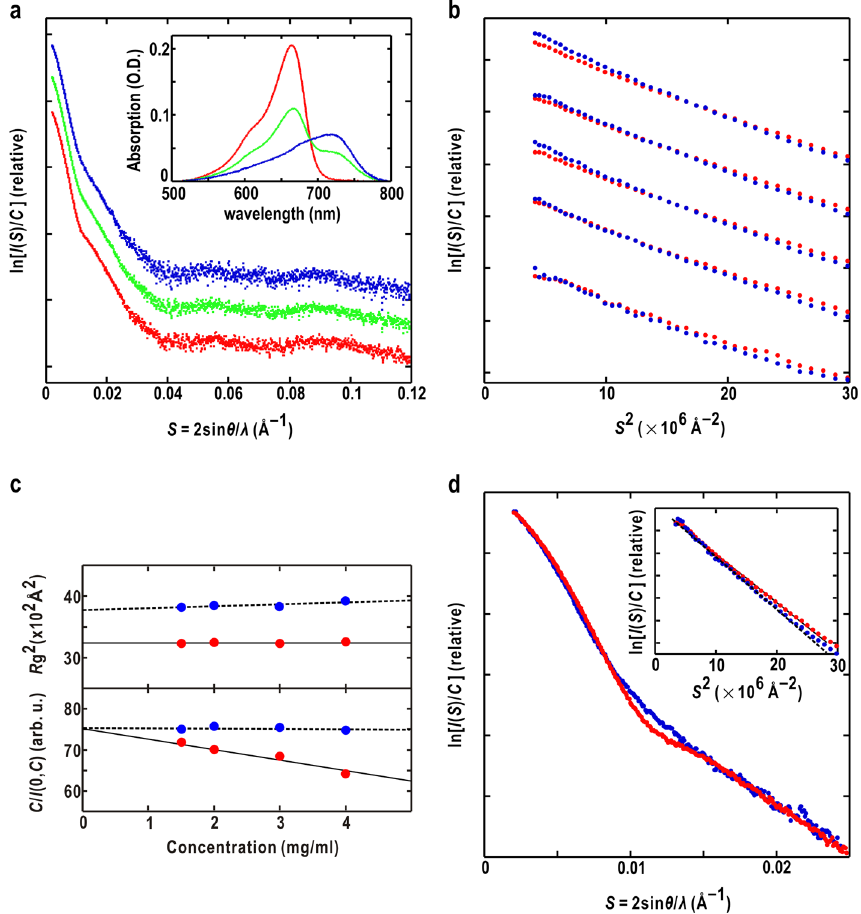
Figure 2. ( a ) SAXS profiles of Pr (red dots) under red light irradiation (green) and Pfr (blue) of LphyA. The Pfr profile was calculated based on the assumption that the population of Pr is 0.39 and the other of Pfr is 0.61, that was estimated from the absorption spectra of Pr (red line) and the steady state (green) in the inset. The Pfr absorption spectrum (blue in the inset) was calculated using the population ratio. ( b ) Guinier plots of Pr (red dots) and Pfr (blue) of LphyA solutions. From lower to upper, the concentrations of LphyA are 0.5, 1.5, 2.0, 3.0, and 4.0 mg/mL, respectively. The Guinier approximations were used for the region from 4 × 10 –6 to 20 × 10 –6 Å 2 . ( c ) Concentration dependencies of R g and the inverse of zero-angle scattering intensities of Pr (red symbols) and Pfr (blue). The variation of the parameters was approximated by linear regression lines. The signs for A 2 of Eq. (4) and B if of Eq. (5) are the same. ( d ) Scattering profiles of Pr (red dots) and Pfr (blue) near the dilution limit estimated from the profiles of the concentration series. The inset shows their Guinier